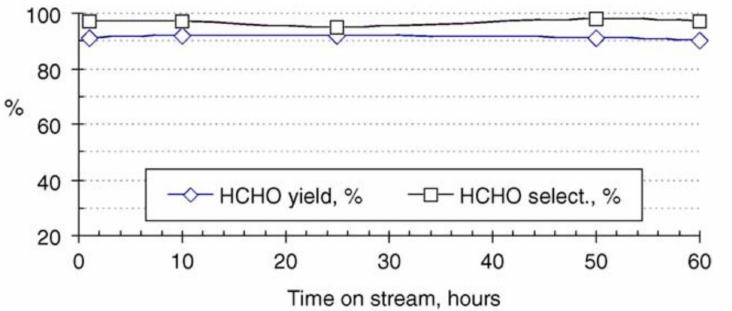
Figure 32. Oxidative dehydrogenation of MeOH over V-Mg-O catalyst at 420 ◦ C, LHSV of 1.5 h − 1 , and CH 3 OH/O 2 of 1/1. Reprinted from [201] Copyright © (2005), with permission from